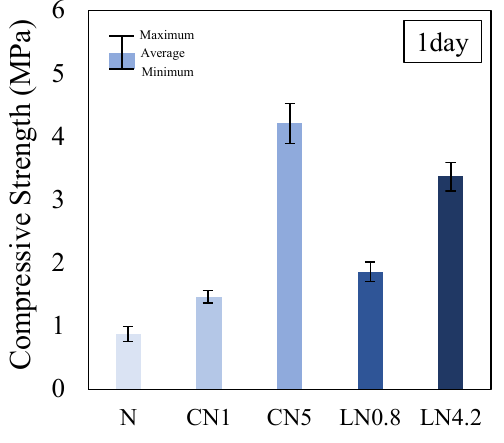
Figure 4. Compressive strength (1 day).